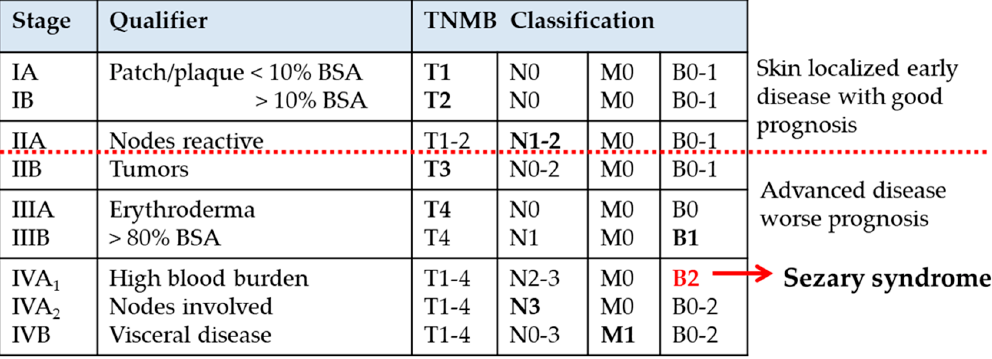
Figure 1. Clinical criteria for staging of mycosis fungoides (MF) and Sézary syndrome (SS). SS is classified as stage IVA 1 disease and is distinguished from MF by a high blood tumor burden. Diagnostic “B2” blood criteria required for SS include Sézary cells ≥ 1000 cells/ μ L, CD4/CD8 ≥ 10, CD4 + CD7 − cells > 30% or CD4 + CD7 − cells ≥ 40%, with an identical T-cell clone detected in blood and skin. Stage IIIB requires B1 blood involvement not meeting the B2 threshold for SS. The most distinguishing qualifier for each stage is noted. The table is adapted from the ISCL/European Organization for Research and Treatment of Cancer (EORTC) classification criteria in Olsen et al. [33]. BSA, body surface area affected. Erythroderma, BSA > 80%.